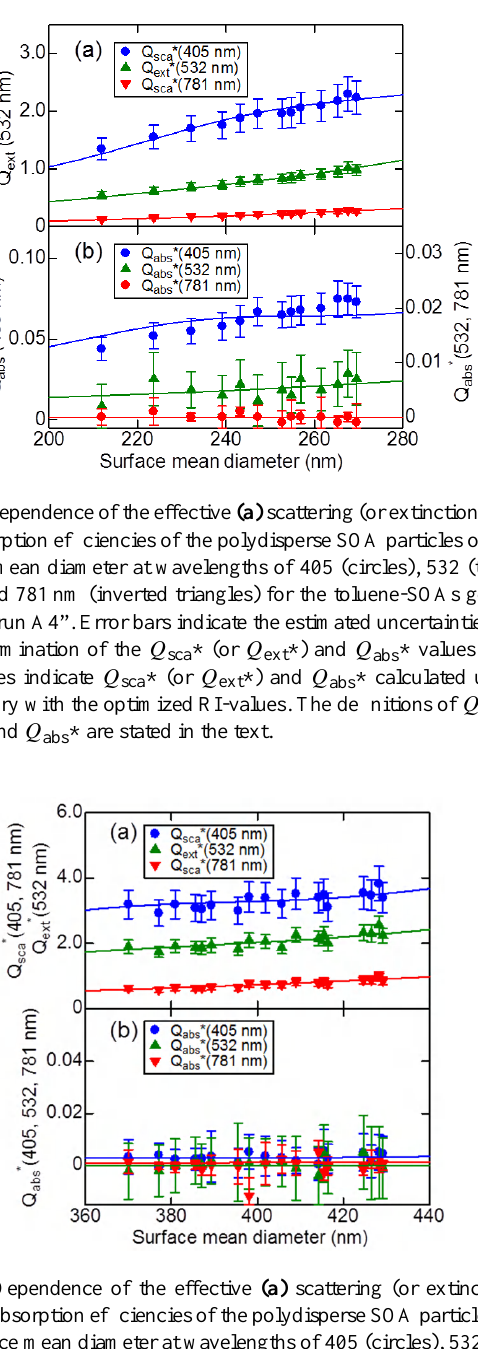
the uncertainties in the calibration factors, in the background interpolations (estimated from the drift between neighboring filtered air measurements), and in the corrections of the gas phase absorption, as well as the detection limit values. The sampling flow rate of the PASS-3 was 1.0